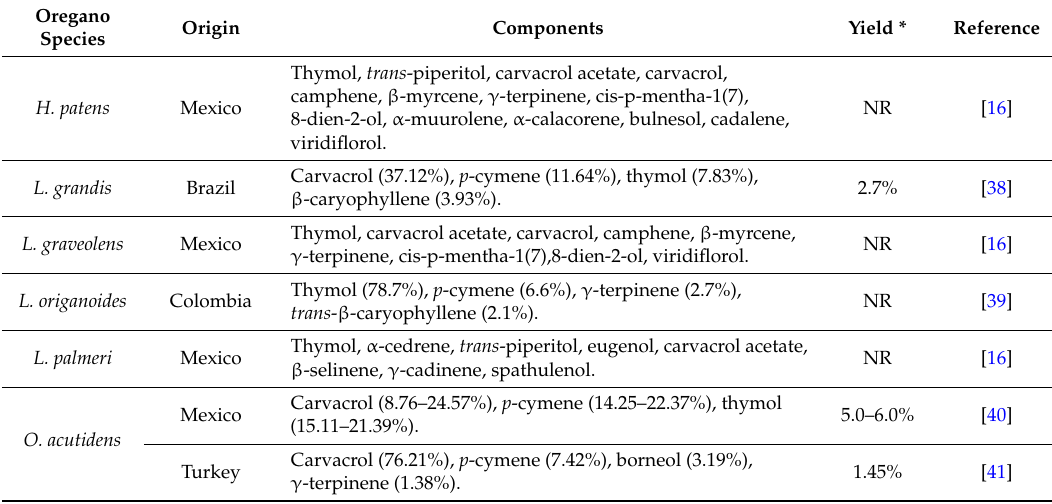
Table 1. Principal components of essential oils of different oregano